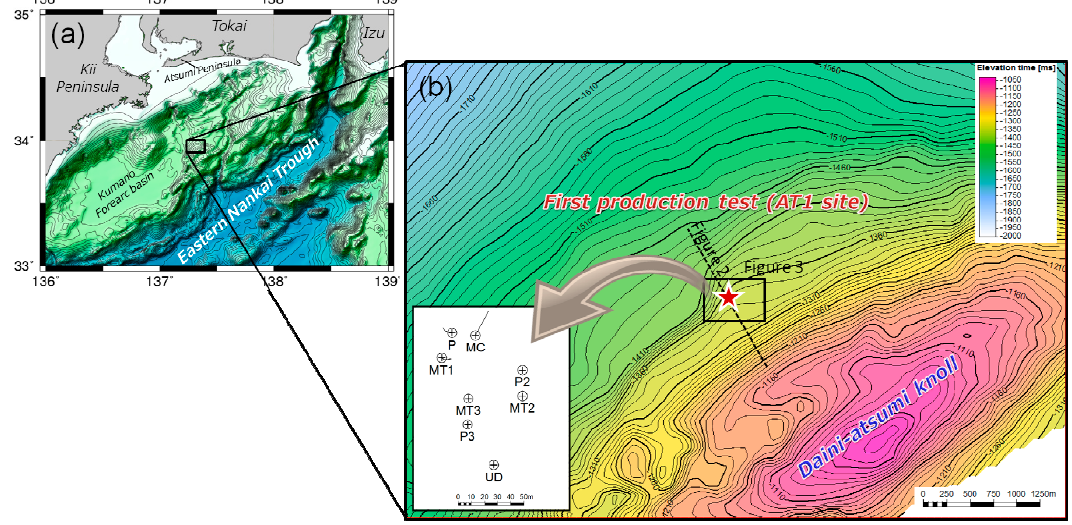
Figure 1. ( a ) Index map of the Tokai-Atsumi-Kumano forearc basin around the eastern Nankai Trough; and ( b ) the seabed structure map (vertical scale is two-way-time (ms)) and well location map around the first and second offshore gas hydrate production test sites.